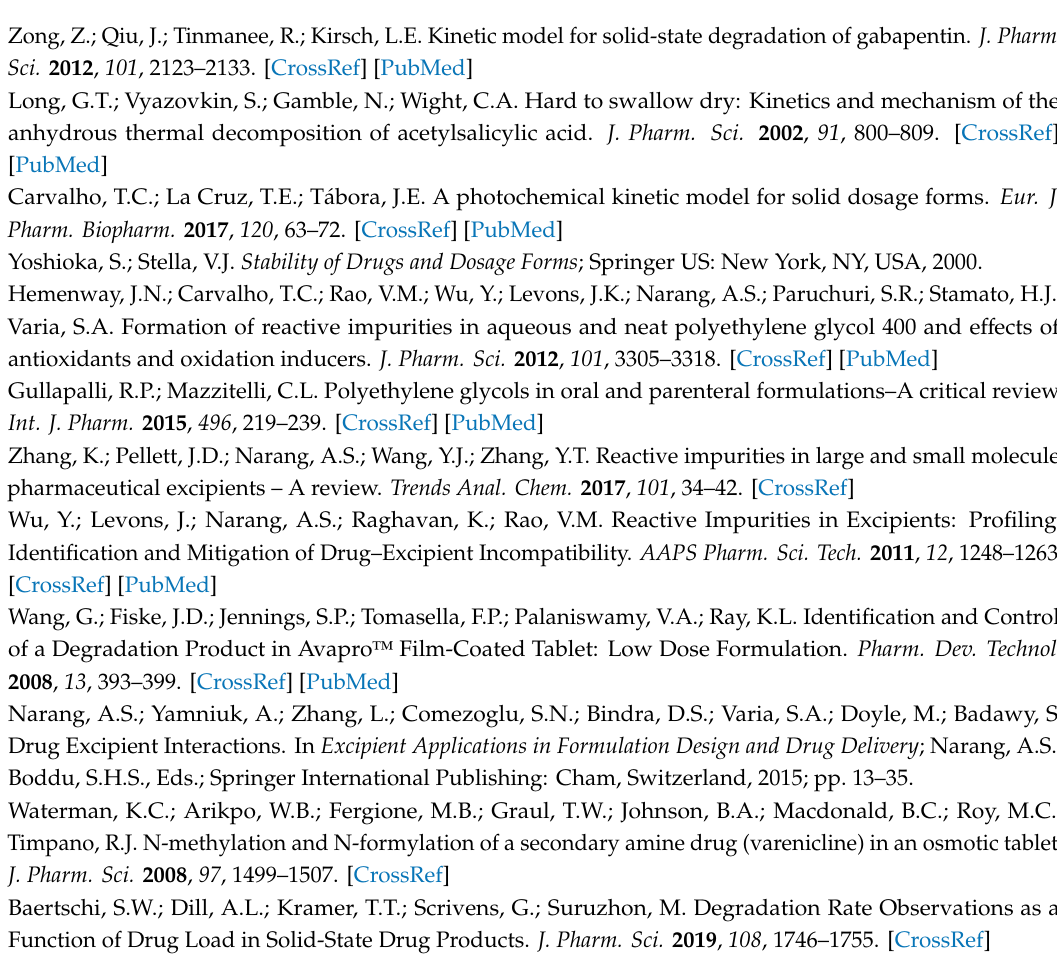
Table S13: Correlation matrix, Table S14: Imported dataset for organic impurities, Table S15: Imported dataset for saxagliptin degradation products, Table S16: Modelled data for organic impurities, Table S17: Modelled data for saxagliptin degradation products, Table S18: Calculated energy for the species involved in the reaction 1 in gas phase and water, Table S19: Calculated energy for the species involved in the reaction 1 in gas phase, water and formic acid, Table S20: Calculated energy for the species involved in the parallel reaction 2 catalyzed by the hydroxyl group in gas phase, water and formic acid, Table S21: Calculated energy for the species involved in the parallel reaction 2 catalyzed by ESCA in gas phase, water and formic acid, Tables S22–S45: Coordinates for compounds used in DFT calculations, Figure S1: Structure of the transition state parallel reaction 1 in gas phase, Figure S2: Structure of the transition state parallel reaction 2 in gas phase catalyzed by the hydroxyl group, Figure S3: Structure of the transition state parallel reaction 2 in gas phase catalyzed by formic acid and ESCA, Scheme S1: Reaction mechanism 1 for parallel reaction 1, Scheme S2: Reaction mechanism 2 for parallel reaction 1, Scheme S3: Reaction mechanism 3 for parallel reaction 1, Scheme S4: Reaction mechanism 1 for for parallel reaction 2 catalyzed by hydroxyl group, Scheme S5: Reaction mechanism 2 for parallel reaction 2 catalyzed by the ESCA, Scheme S6: Reaction mechanism 3 for parallel reaction 2 catalyzed by formic